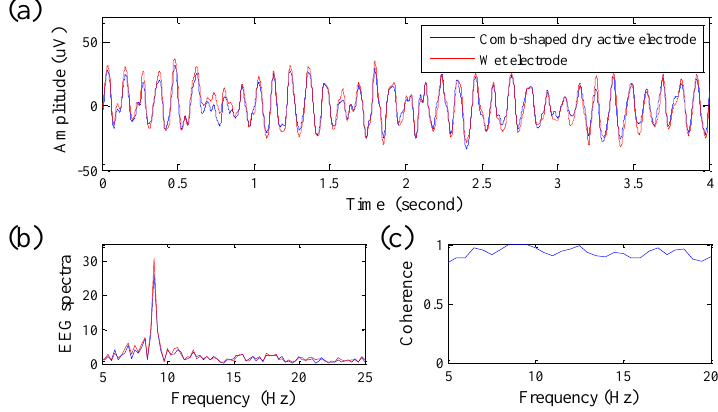
Figure 5. ( a ) EEG signals and ( b ) EEG spectra for the experiment of alpha rhythm; and ( c ) their coherence corresponding to different frequencies.